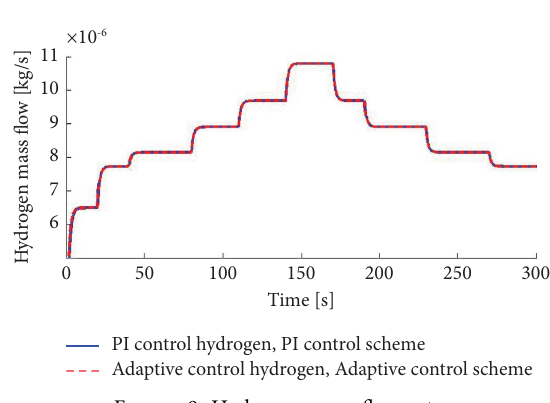
Figure 9: Hydrogen mass fow